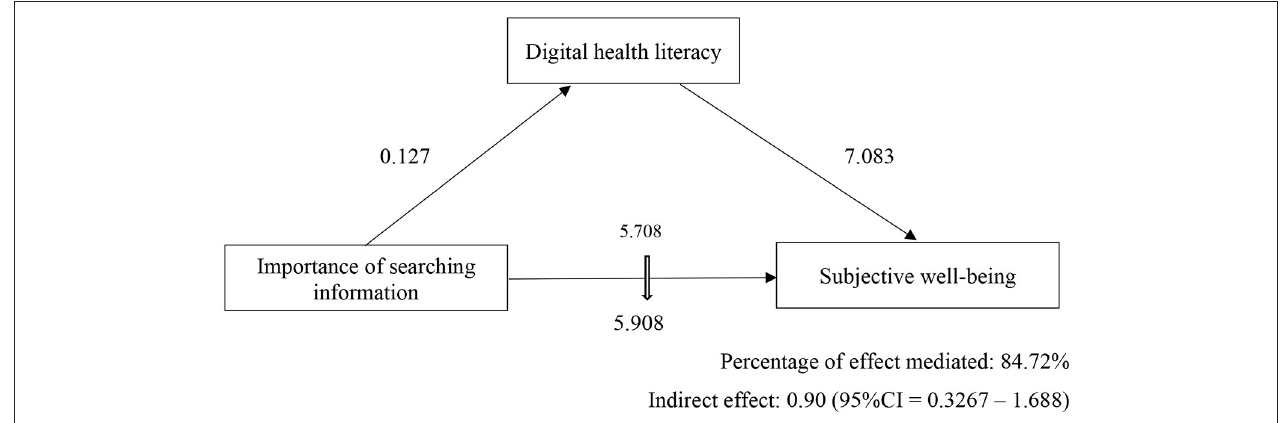
FIGURE 2 | Digital health literacy mediates the relationship between the importance of searching information and subjective well-being ( n =